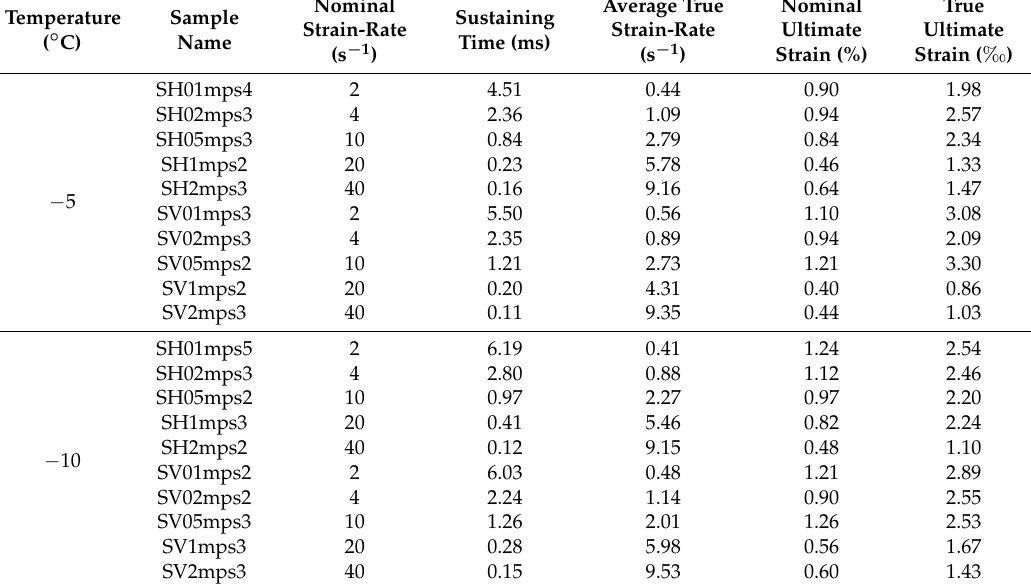
Table 4. Ultimate strain and strain-rate results of soft ice derived from actuator displacement and DSCM. SH denotes soft ice sample loaded in the horizontal direction, SV denotes soft ice sample loaded in the vertical